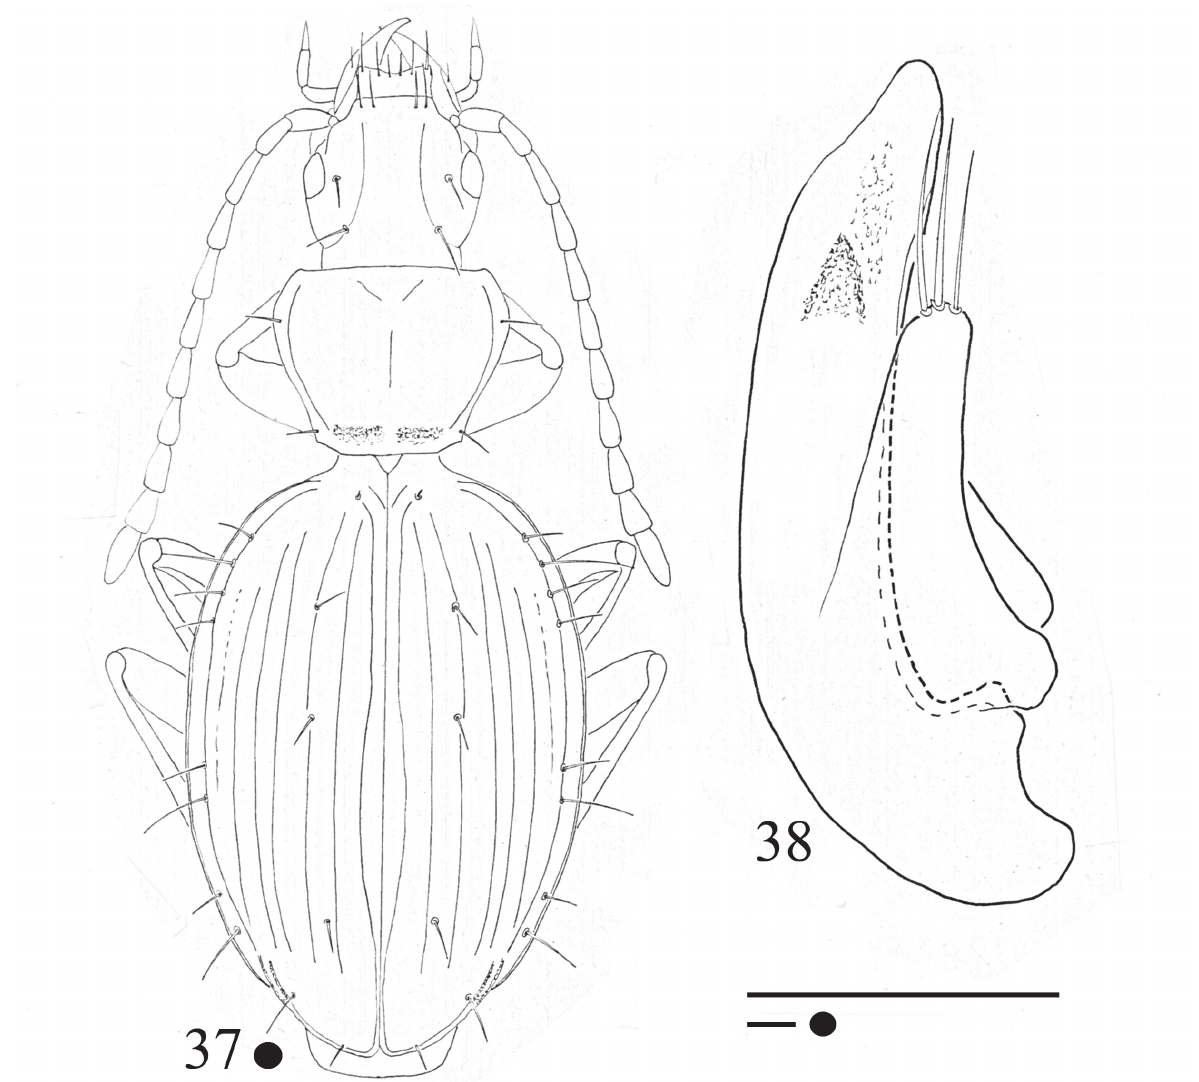
Figs 37-38. Habitus (37) and aedeagus in lateral view (38) of Tasmanorites flavipes (Lea), ♂ from Khazad Dûm cave, Junee-Flor- entine. Scale: 0.2